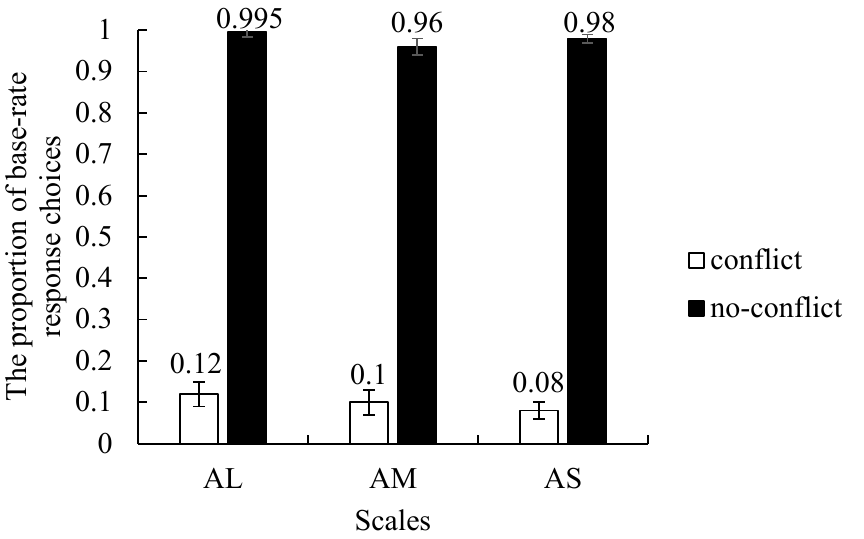
Figure 1. The proportion of base-rate response choices for each condition. Error bars are standard errors.